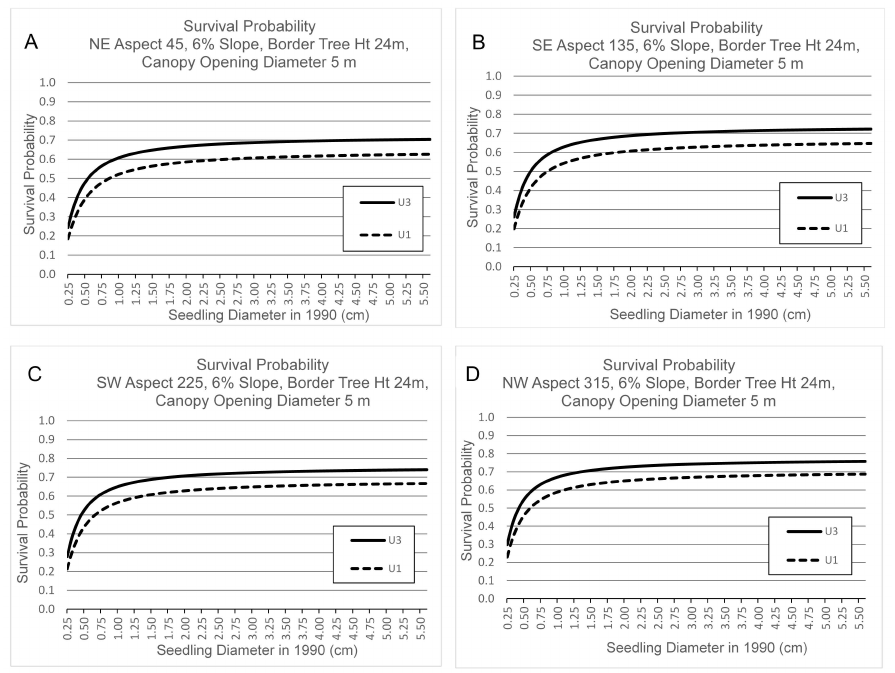
Figure 2. The relationship between seedling diameter, survival probability and understory treatment (U3 is understory treatment with an herbicide applied to cut stems, U1 refers to no understory treatment). ( A )–( D ) With 6% slope, canopy border tree height of 24 m, and canopy opening diameter of 5 m.